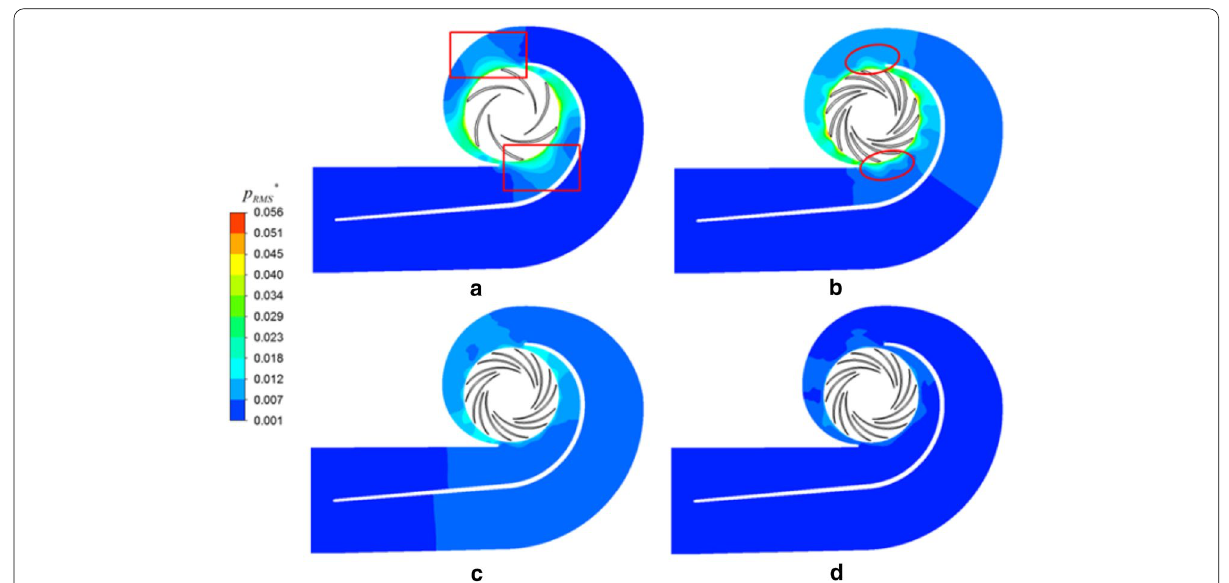
Figure 14 Contour of the dimensionless RMS pressure on the middle surface of the volute for the four models